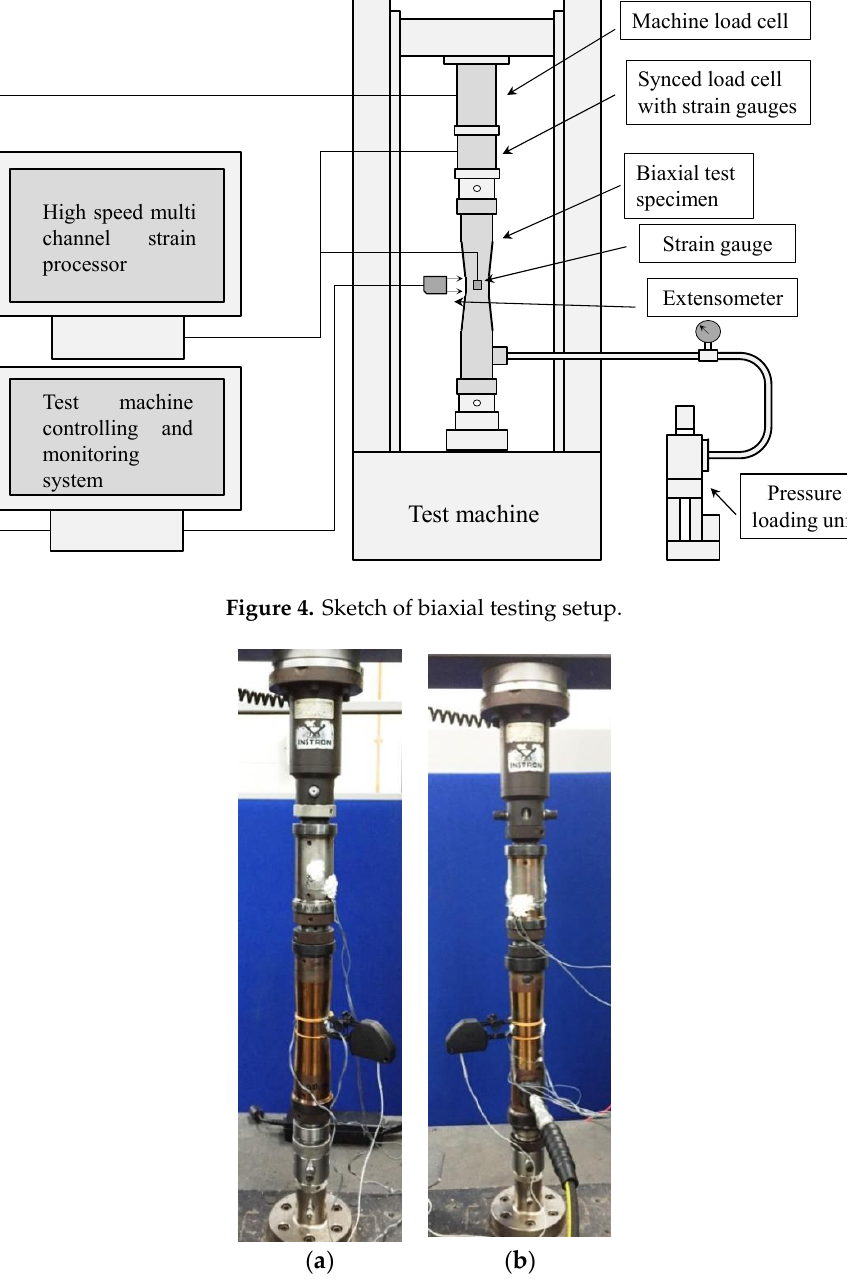
Figure 5. Experimental setup of specimens: ( a ) Uniaxial ( b ) Biaxial.